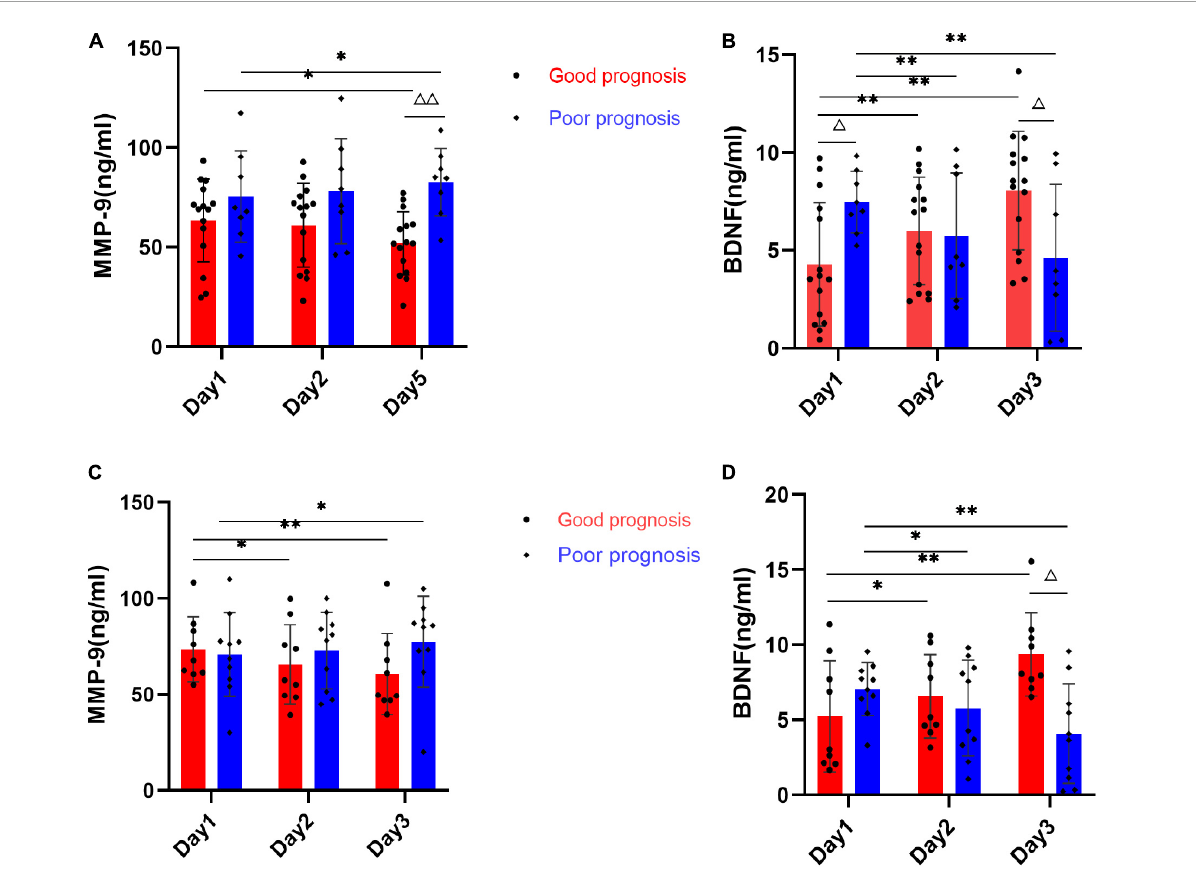
FIGURE4 Average serum MMP-9 and BDNF levels of AIS patients with or without thrombolysis at Day 1, Day 2, and Day 5 time points. (A) Bar graph shows quantitative analysis for serum MMP-9 of patients with non-thrombolysis between good prognosis group ( n = 15) and poor prognosis group ( n = 8). (B) Bar graph shows quantitative analysis for serum BDNF of patients with non-thrombolysis between good prognosis group ( n = 9) and poor prognosis group ( n = 10). (C) Bar graph shows quantitative analysis for serum MMP-9 of patients with thrombolysis between good prognosis group ( n = 15) and poor prognosis group ( n = 8). (D) Bar graph shows quantitative analysis for serum BDNF of patients with thrombolysis between good prognosis group ( n = 9) and poor prognosis group ( n = 10). Data represent as mean ± SD, ∗ P < 0.05, ∗∗ P < 0.01 vs. Day 1 time points, (cid:49) P < 0.05, (cid:49)(cid:49) P < 0.01 vs. group with good